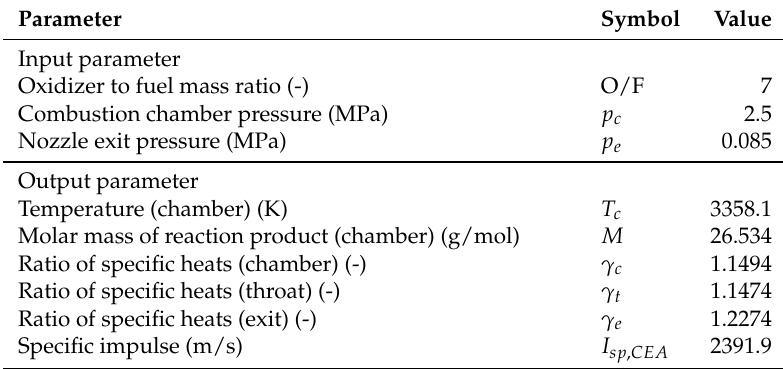
Table 3. Input data and results of CEA